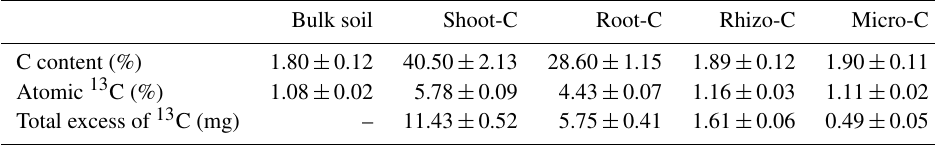
Table 1. Carbon (C) and atomic 13 C contents and amount of 13 C added to untreated bulk soil and soils treated with one of four labelled C substrates.